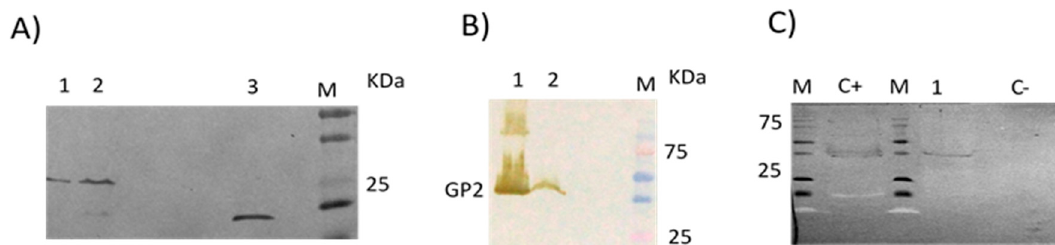
Figure 1. ( A ) Expression of the recombinant CAT protein (28 KDa) in the pellet (lane 1) and the supernatant (lane 2) of the crude extracted lysate by Immunoblot, revealed with anti-His antibody (His Tag Mouse mAb HRP conjugate, dilution 1:2500), and anti-mouse IgG, HRP-link antibody, as a secondary antibody (dilution 1:2000). A non-related His-recombinant protein, treated in the same conditions, was loaded as a reaction positive control (lane 3). ( B ) Expression of the recombinant Lloviu Virus (LLOV) GP 2 protein (40 KDa) in the supernatant (lane 1) and pellet (lane 2) of the crude extracted lysate, revealed with the same antibodies and conditions. M = Molecular weight markers. ( C ) Reactivity of one of the 7 positive serum pools from M. schreibersii bats of Cantabria caves (C5, Table 1) (lane 1) by Immunoblot. An anti-LLOV glycoprotein (GP), polyclonal mouse serum (dilution 1:200) was used as positive control (C + ). As negative control (C-), the same amount of CAT crude extract was used, revealed with the same antibodies and conditions.